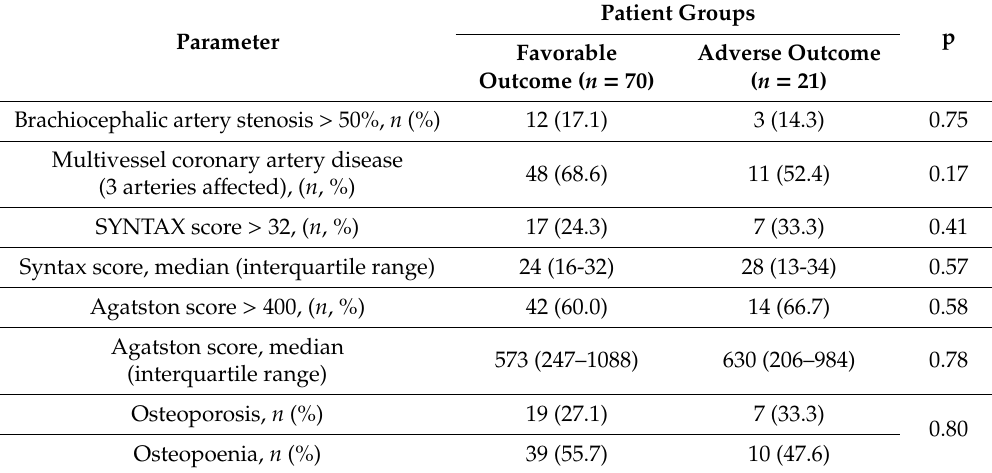
Table 3. Color duplex screening, coronary angiography, and multislice spiral computed tomography results in relation to the adverse cardiovascular outcome after coronary artery bypass graft (CABG) surgery ( n = 91).